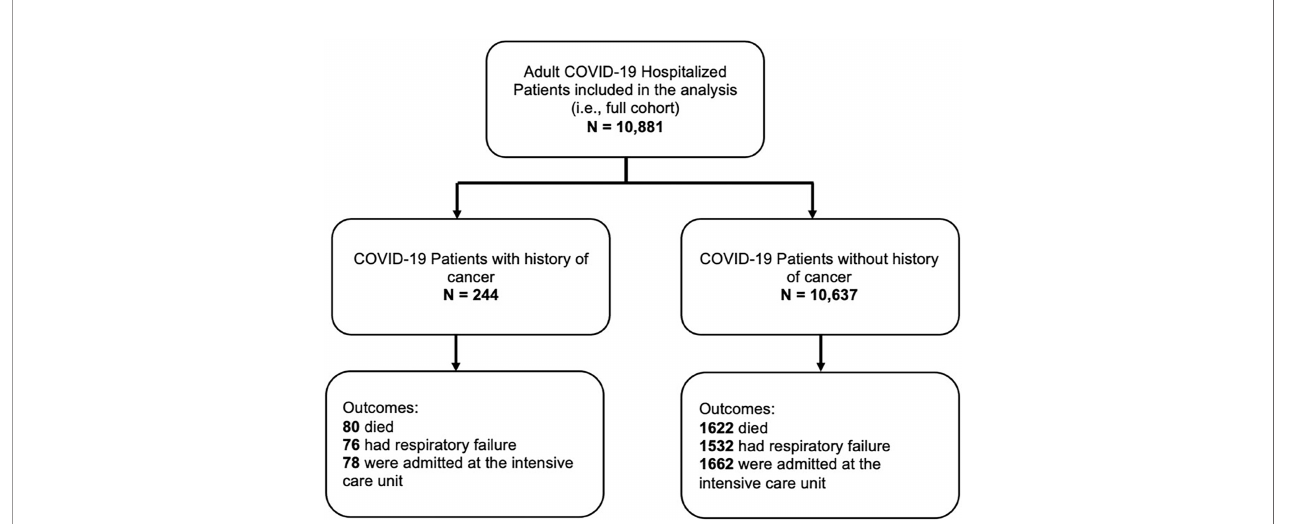
FIGURE 1 | Flow of